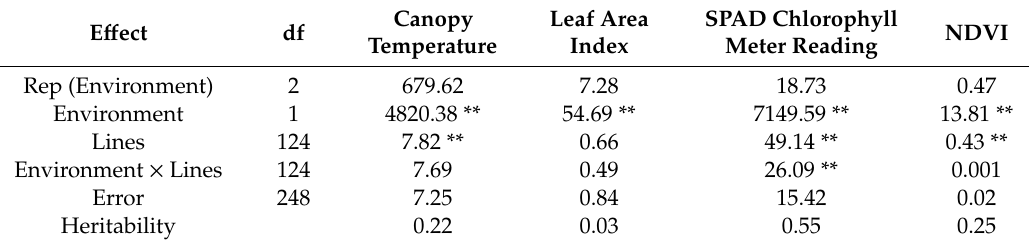
Table 1. Mean squares of four physiological traits of groundnut mini core